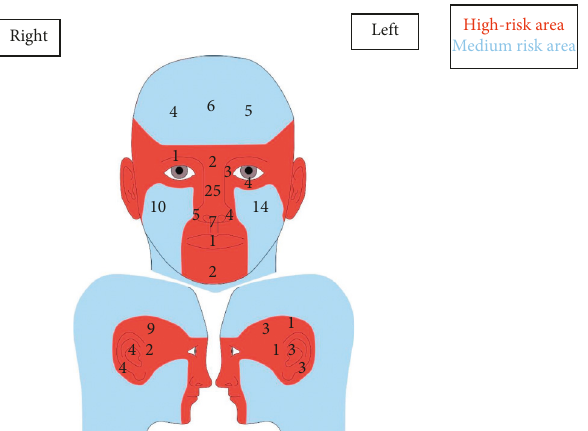
Figure 2: Distribution of basal cell carcinoma tumours on the face ( n � 126). The area in red is the high-risk mask area of the face ( n � 87), and the blue area signifies the rest of the face, which is a medium risk ( n �